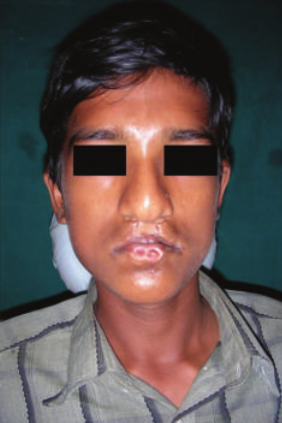
Figure 1: Frontal view of the patient showing midface retrusion and a repaired bilateral upper cleft lip.